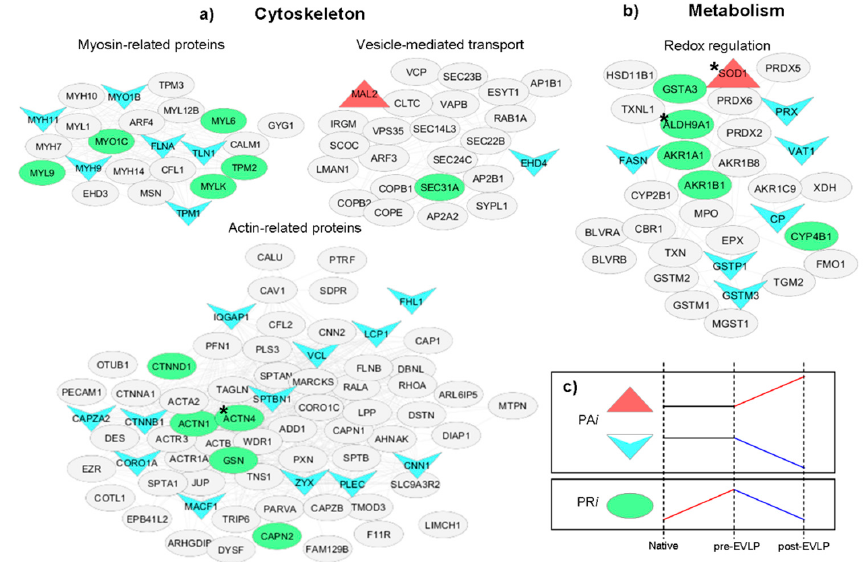
Figure 6. Main pathways involved in the proteome remodeling induced by the EVLP procedure. Enriched subnetworks based on recovered and activated proteins after ANOVA (<0.05) and Tukey’s test (<0.05; * <0.08). These statistically significant proteins were previously extracted using an unbiased procedure that evaluated simultaneously the changes in the proteome in the three conditions: native, pre-EVLP, and post-EVLP. Recovered proteins, marked as a green/circle, were extracted using the Proteome Remodeling index (PRi); while activated proteins marked as red/triangle and blue/arrow for up- and downregulated in post-EVLP, respectively, were extracted using Proteome Activated index (PAi). The application of PRi and PAi filters highlights an enrichment in ( a ) vesicle-mediated transport, myosin-, and actin-related proteins, belonging to cytoskeleton and ( b ) redox regulation, belonging to metabolism. The blank nodes identify the protein descriptors resulted outside the applied PRi and PAi filters. ( c ) Summary of considered trends of remodeled proteins. The complete lists of PRi and PAi extracted proteins are reported in Supplementary Tables S5,6.